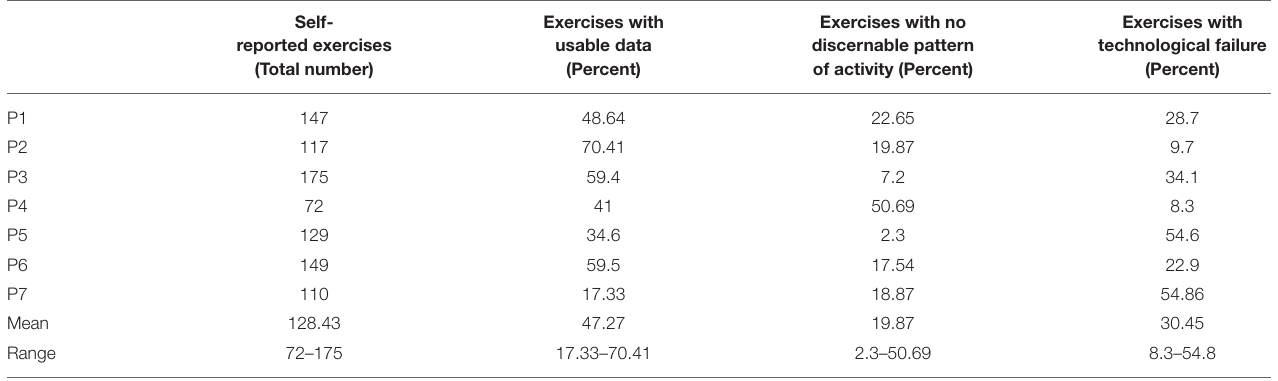
TABLE 1 | Categorization of data capture and comparison to self-reported practice.